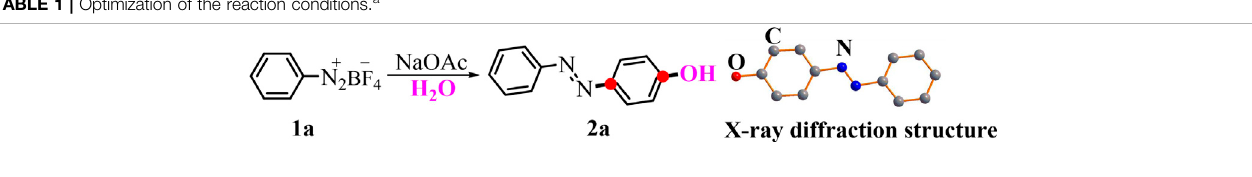
TABLE 1 | Optimization of the reaction conditions.